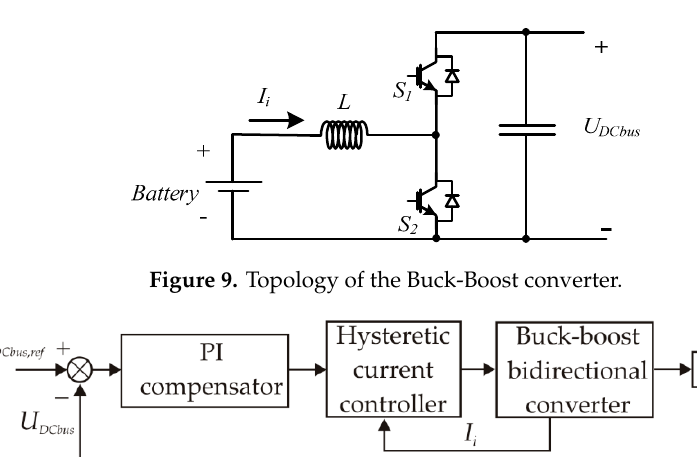
Figure 12. Block diagram of the DC-DC converter closed loop control system.